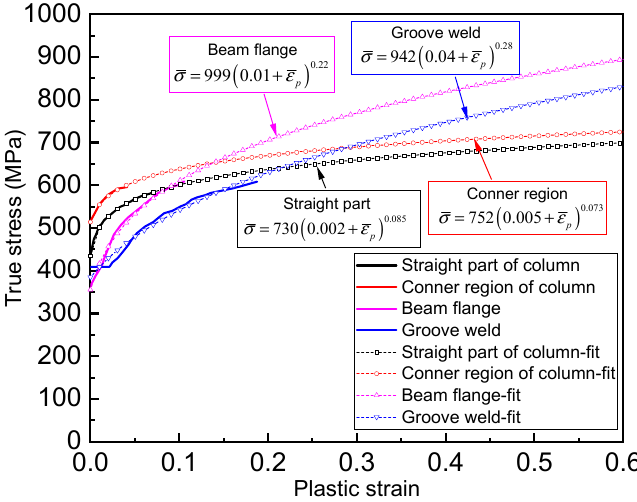
Figure 8. The true stress–plastic strain of each material used for the RP-1 specimen.